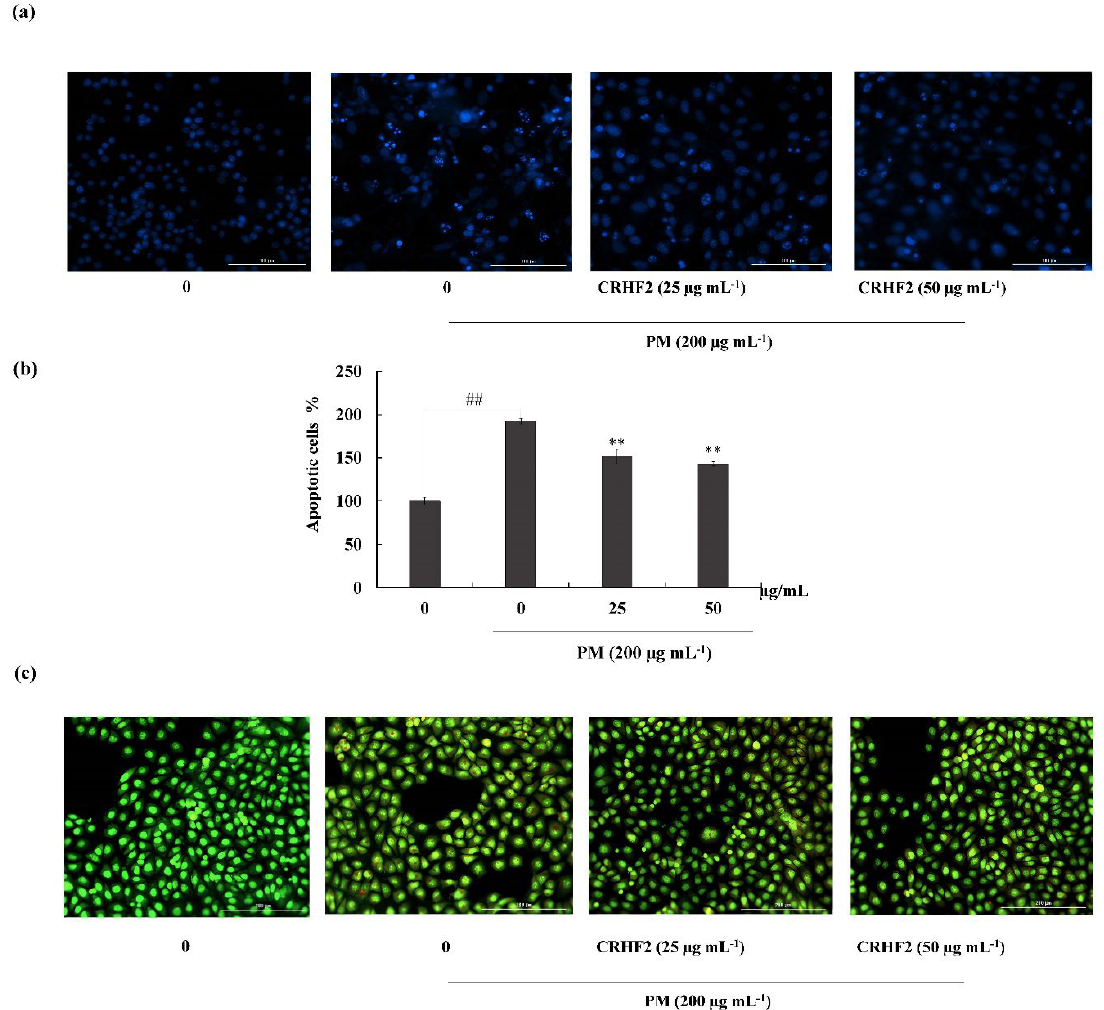
Figure 3. CRHF2 attenuates PM-stimulated apoptotic body formation and DNA damage. Evalua- tion of nuclear morphology via ( a ) Hoechst 33342 staining fluorescence images ( b ) apoptotic cell percentage, and ( c ) ethidium bromide and acridine orange-involved double staining. Experiments were triplicated to confirm their repeatability (n = 3), ** p < 0.01 (# denotes significance compared to control, while * denotes significance compared to PM-treated groups).